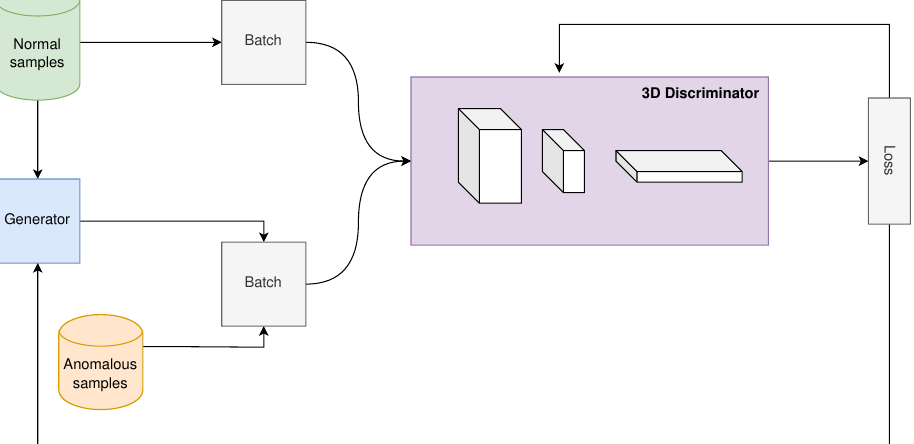
Figure 3. Architecture of the proposed GAN during training. The generator takes normal video samples and creates anomalous ones. Each training batch contains normal samples and anomalous samples—75% of which come from the generator and 25% of which come from real data. At each step of the training, the loss of the discriminator is used to update the discriminator’s weights and also as a parameter to tune the